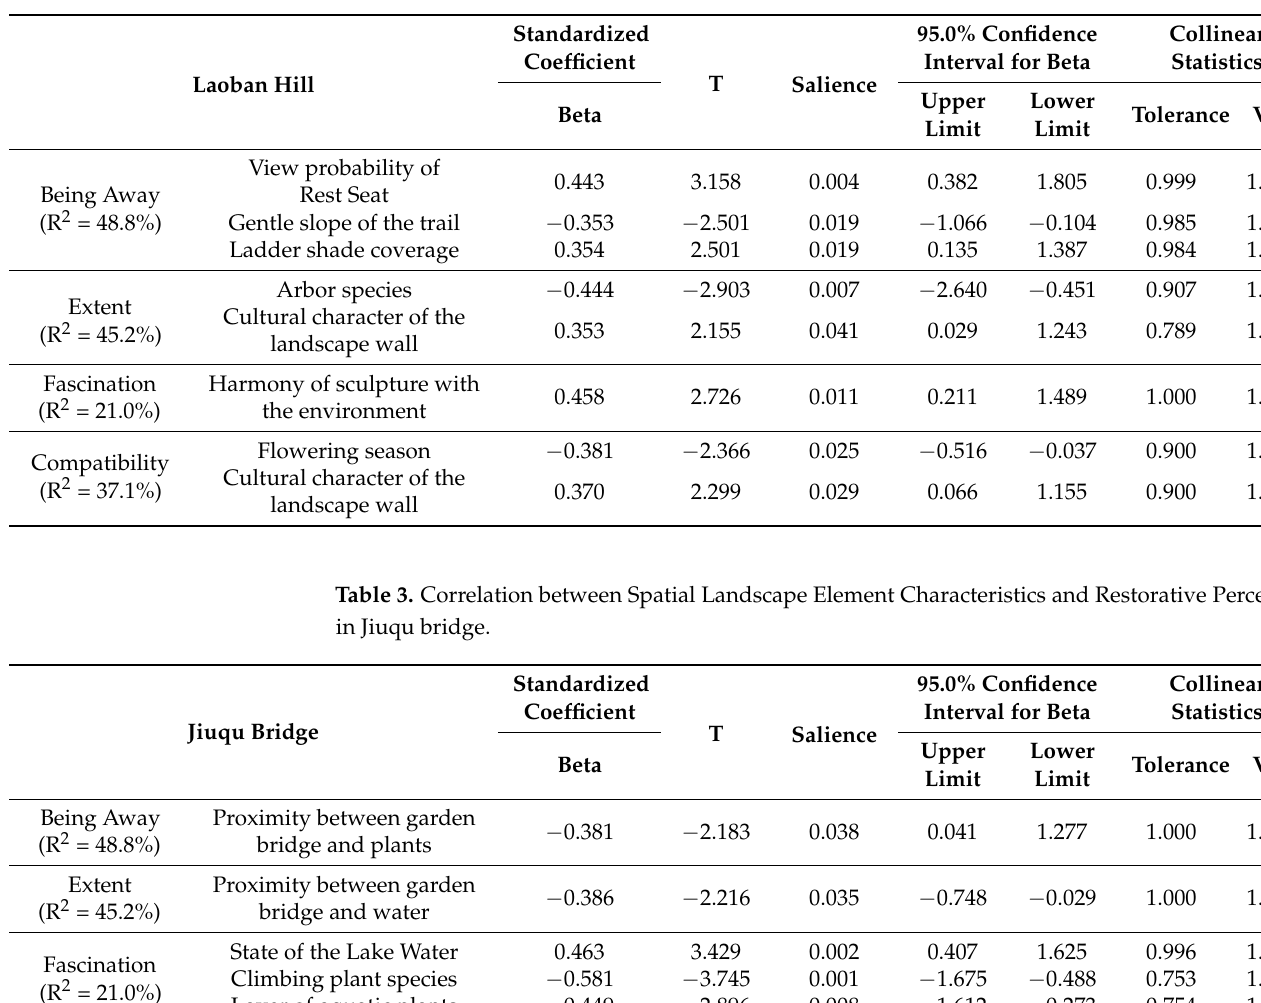
Table 2. Correlation between Spatial Landscape Element Characteristics and Restorative Perception in Laoban hill.